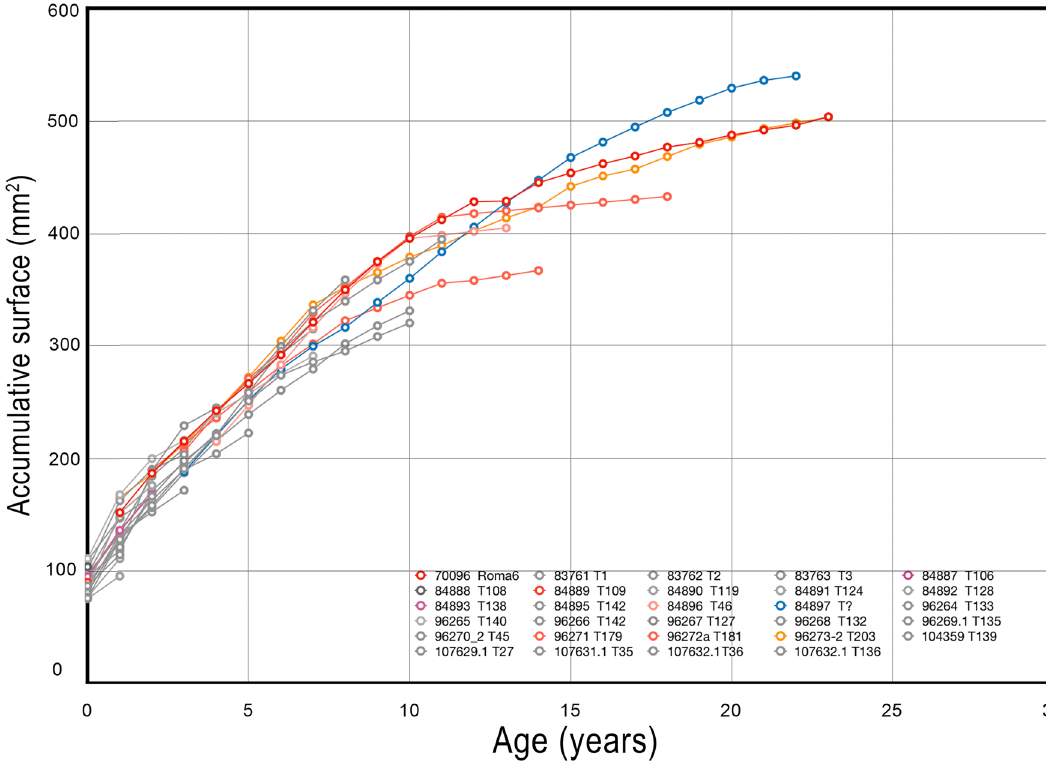
Figure 8. Accumulative bone area in transversal sections of 29 P. falconeri tibiae up to the age of 23 years when growth in bone circumference almost completely ceases. For simplicity, each consecutive annual surface area was calculated including the area of the medullary cavity (see “Materials and methods”). Grey: juveniles that died before onset of puberty; various shades of red and blue: individuals that survived onset of puberty. Individuals older than 15 years (adults) were likely much older than indicated by their last countable LAG because of the almost complete cessation of appositional growth a few years after onset of SM. Thus, for instance, small-sized (probably female) individual 70,096 (Roma6) shows a complete fusion not only of epiphyses but even of tibia and